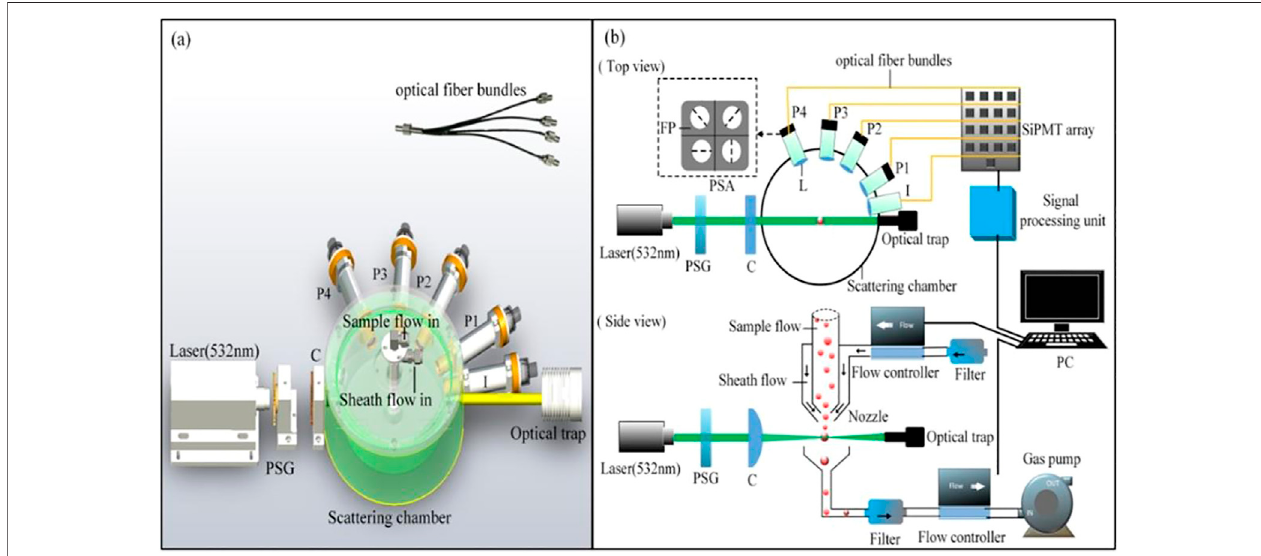
FIGURE 1 | (A) Overview of structure of measuring instrument; (B) schematic diagram of experiment setup. PSG, polarization state generator (composed of a polarizing prism with a quarter wave plate for R mode and a half wave plate for H and P mode); C, cylindrical lens; L, spatial fi lter module (composed of a lens and an aperture); P1-P4, scattered light polarization signal channel at four angles (30 ° , 60 ° , 85 ° , 115 ° ); I, scattered light intensity signal channel at 10 ° ; PSA, polarization state analyzer; FP, fi lm polarizer; PC, personal